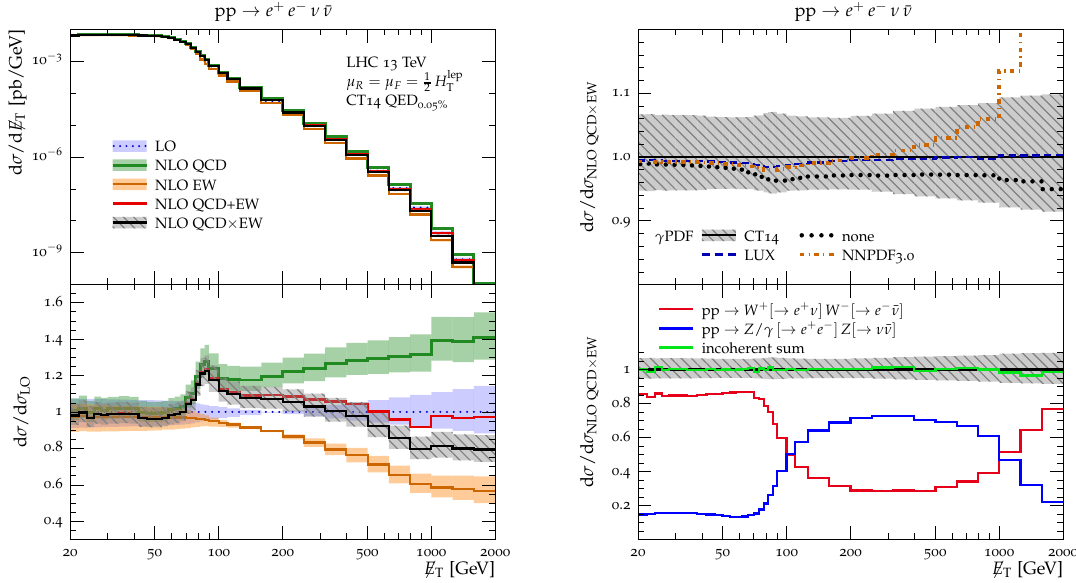
Figure 18 . Distribution in the missing transverse momentum, Details as in (cid:12)gure 16.